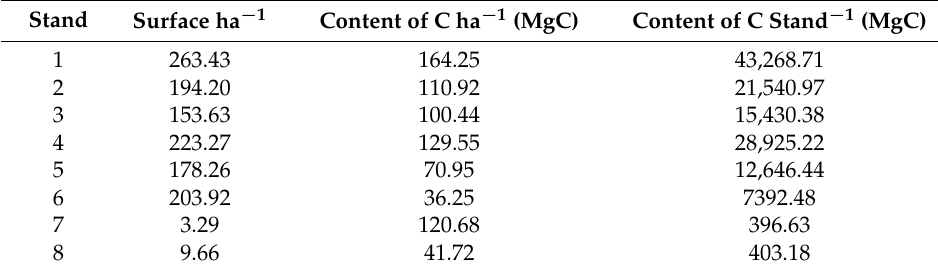
Table 4. Carbon content per hectare and per stand in megagrams.